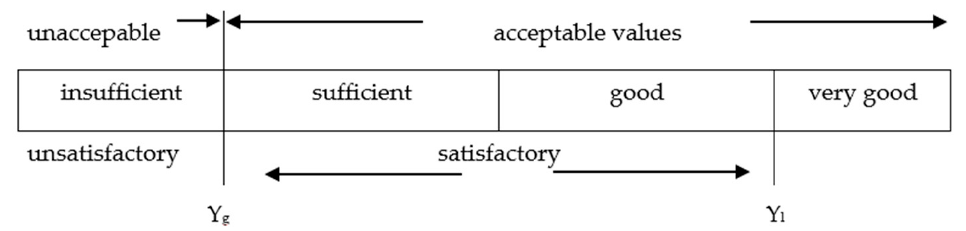
Figure 3. Selection of the range of satisfactory values for the criterion Y.